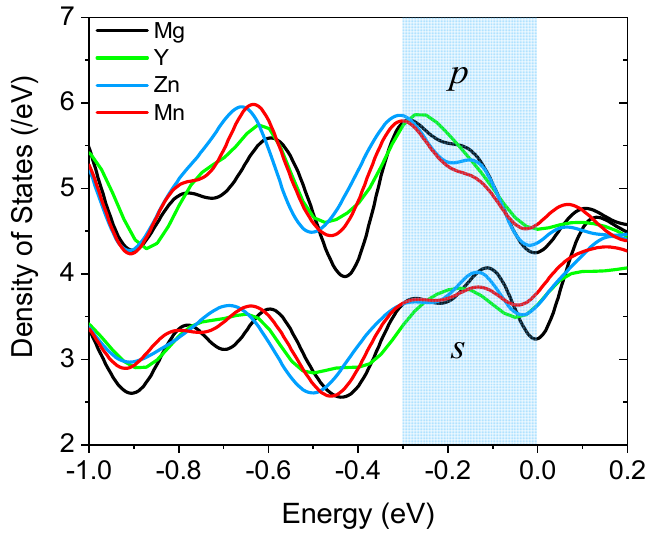
Figure 4. The total density of s - and p -states near the Fermi energy (set to zero) of the supercell with and without segregated alloying elements.